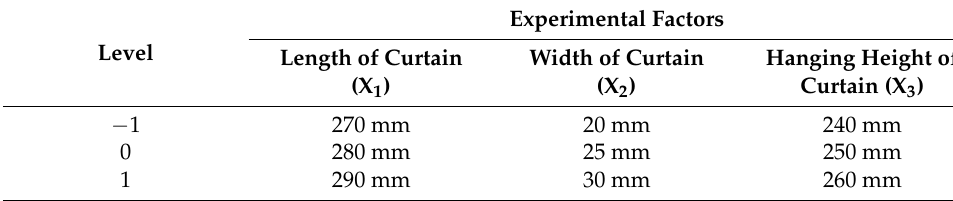
Table 1. Levels and codes of experimental factors.